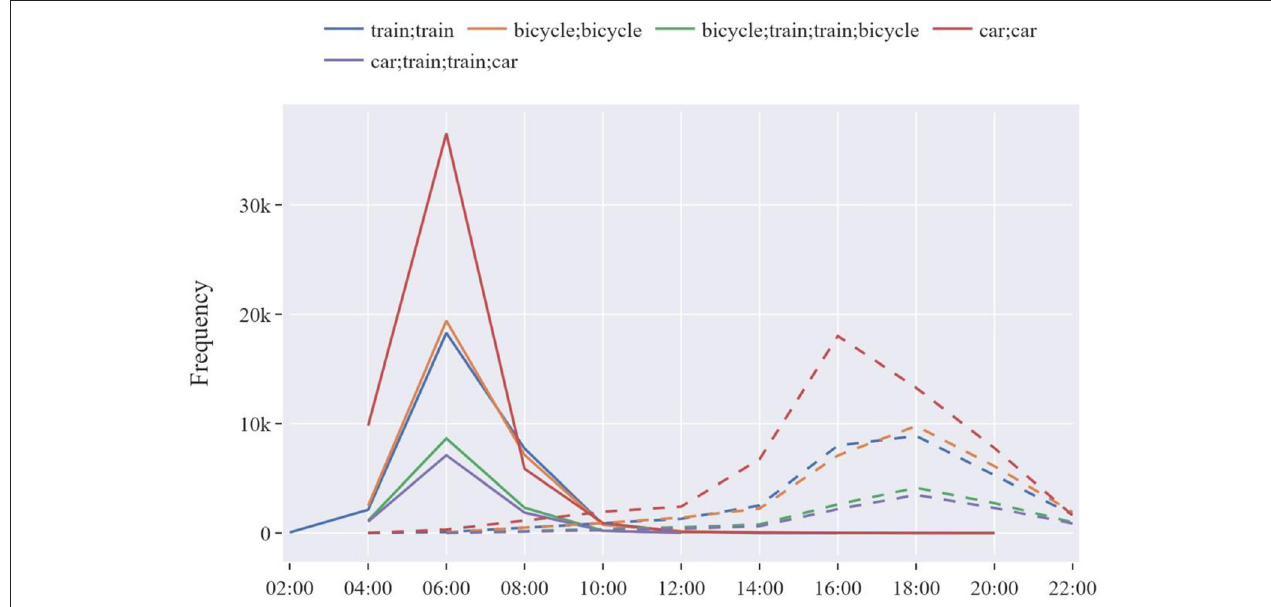
FIGURE 12 | Diurnal distribution of departures from (Top) and to (Bottom) home by transport mode